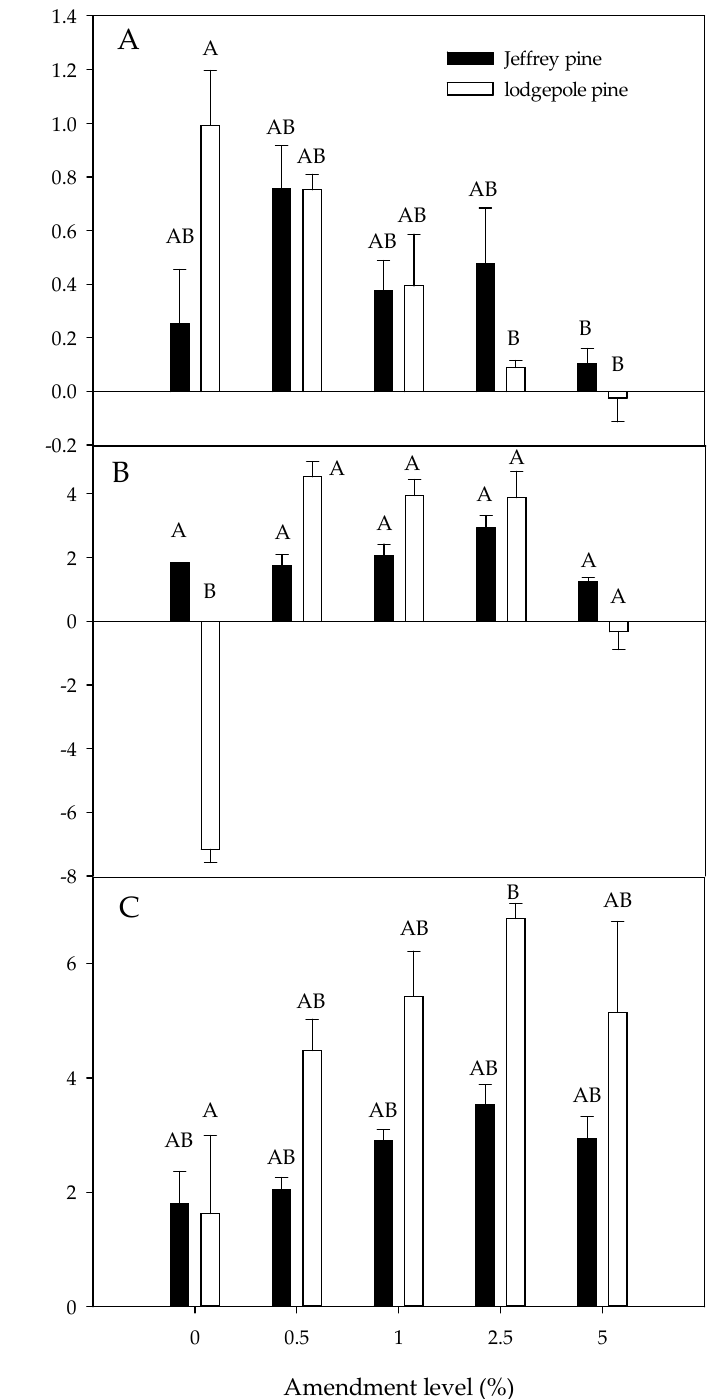
Figure 5. Potential nitrification rate as a function of the charcoal amendment level for both Jeffrey pine and lodgepole pine soil treatments at day 0 ( A ), day 30 ( B ), and day 64 ( C ). Day 0 represents the first measurement day following a one-week pre-incubation period. Error bars represent standard error of the mean ( n = 3). Different letters indicate significant differences ( p < 0.05) across soil types and amendment levels.